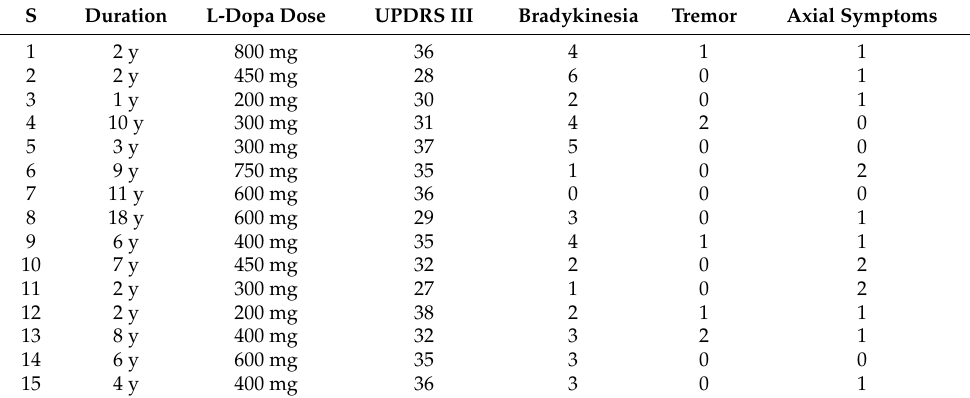
Table 2. Clinical characteristics of included